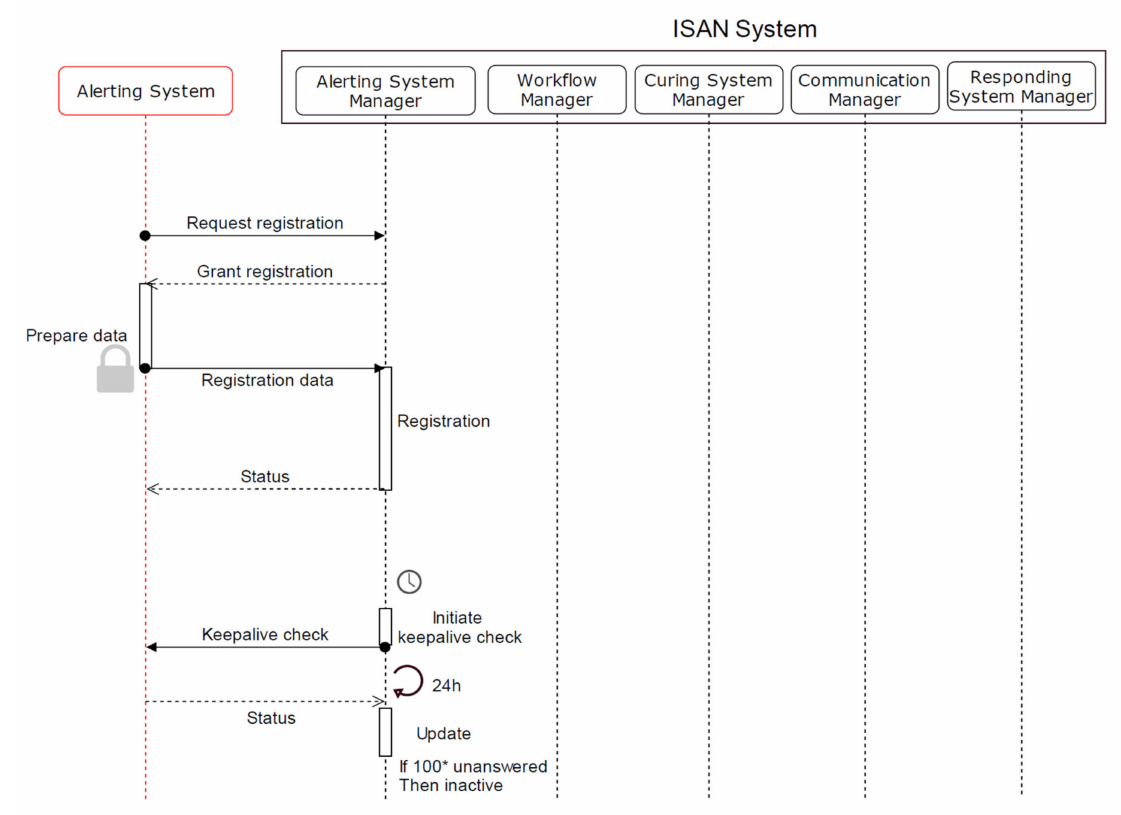
Figure 2. Registration of alerting